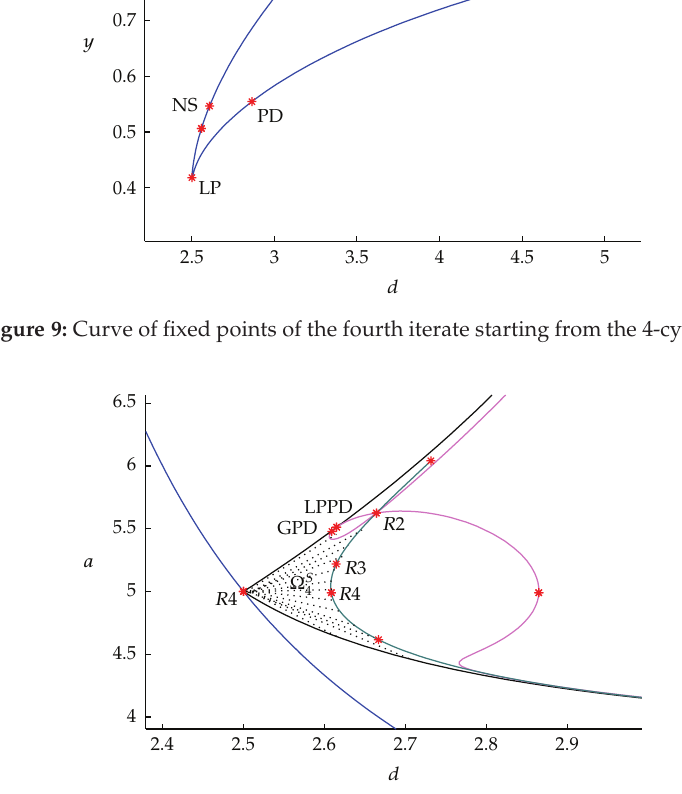
Figure 10: Stability region Ω 4 S of the 4-cycle C 4 . The boundaries consist of NS, LP 4 , PD 4 , and NS 4 curves. with control parameter d . The output of this continuation, Run 7 , is given below. The curve is presented in Figure